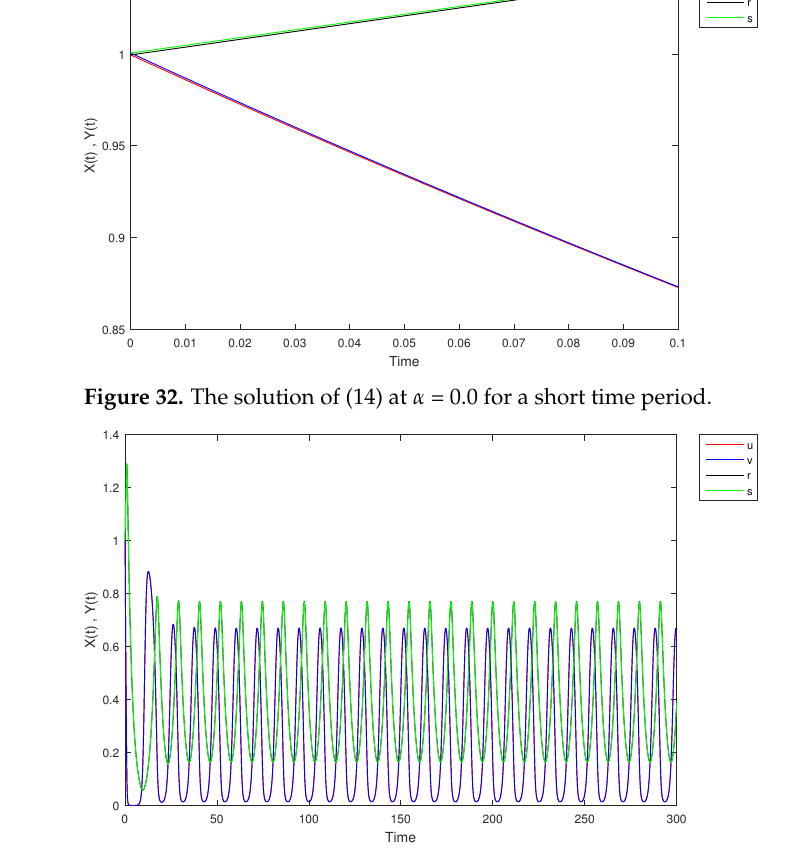
Figure 33. The solution of (14) at α = 0.0 as time